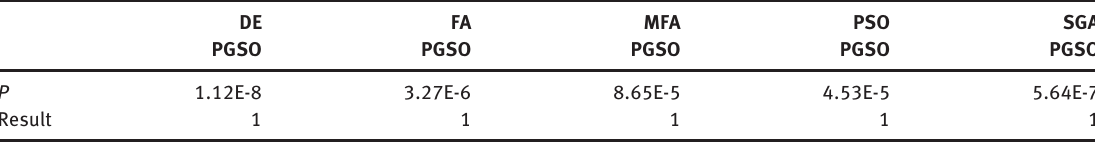
Table 4. Result of Wilcoxon Rank Sum Test.